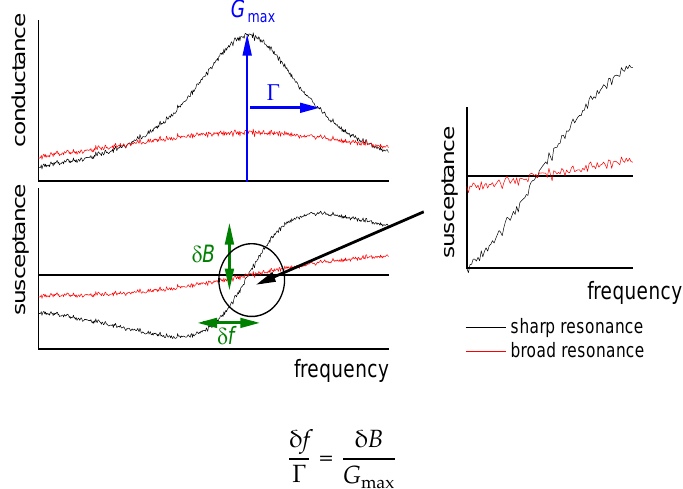
Figure 9. When a resonance becomes broader, this lowers the precision in the determination of the frequency shift twice. Γ increases and G max decreases (both in proportion to the inverse Q-factor). The noise on δ B is assumed to be independent of Q in this argument.